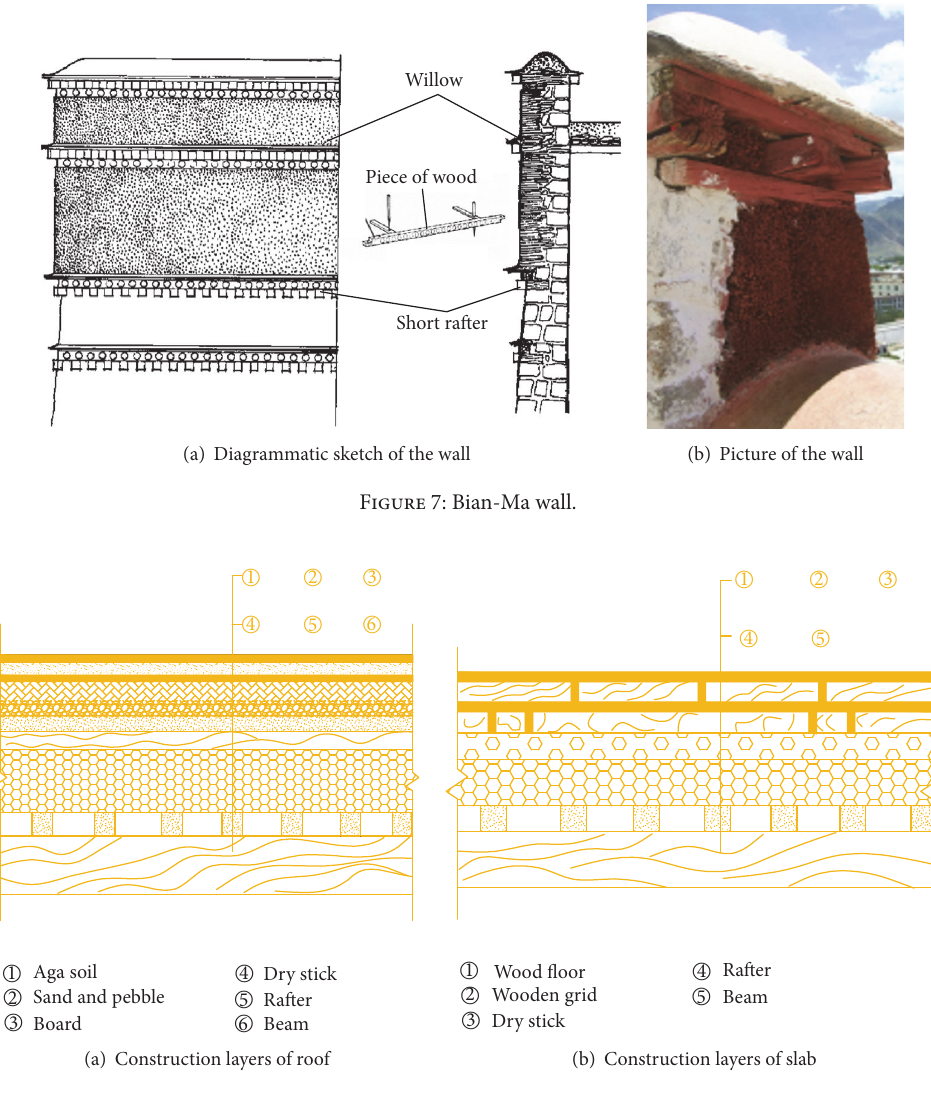
Figure 8: Construction layers of roof and